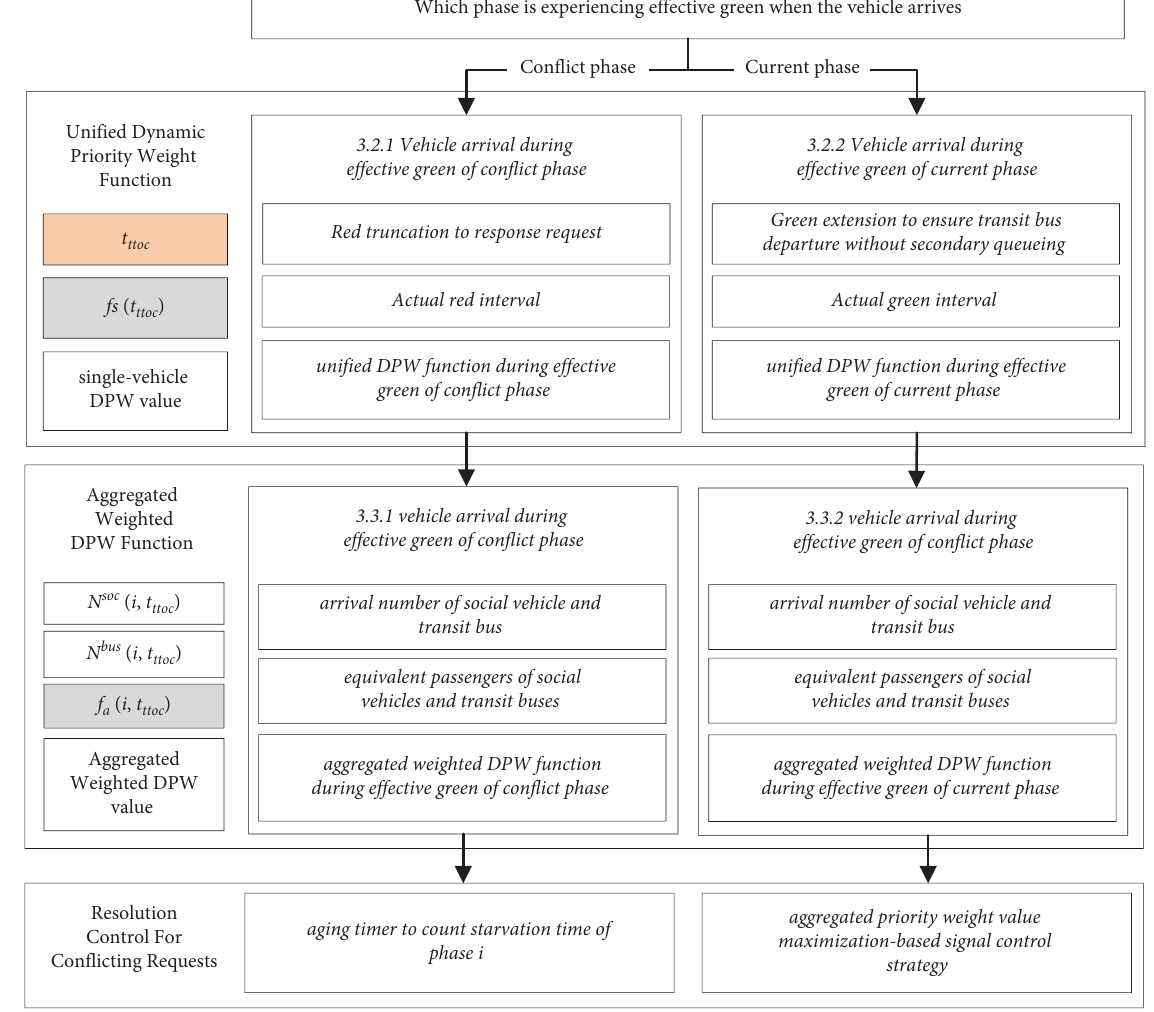
Figure 2: Te framework of the proposed conception. Table 1: Notation